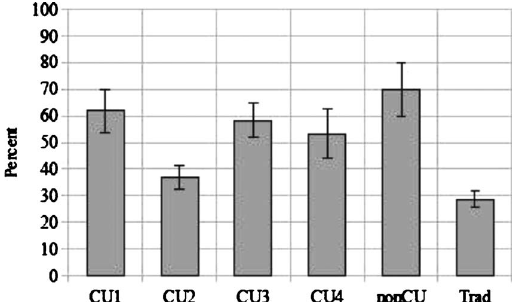
FIG. 2. Average percentage correct on CUE question 17. The number of students in each group who took the CUE postinstruction are as follows: CU1=20, CU2=42, CU3=27, CU4=35, nonCU =31, and